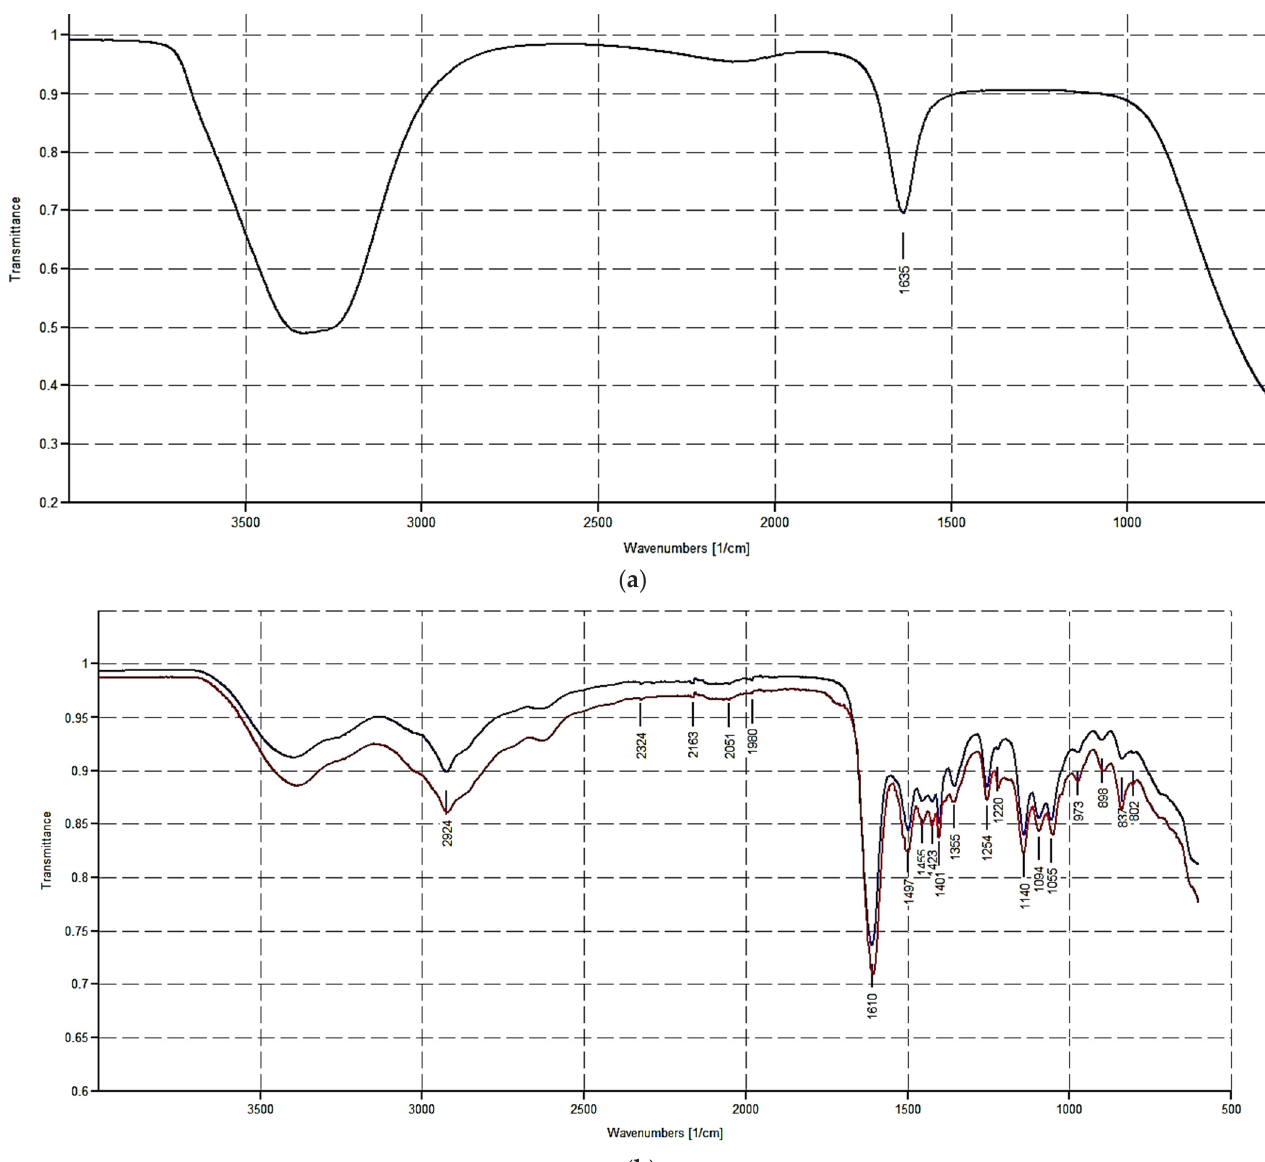
Figure 3. ATR-FTIR spectra of soaked CP1_1.1-Hgel ( a ) and of dried CP1_1.1-Hgel (black line) compared with the spectrum of CP1 (red line) ( b ).